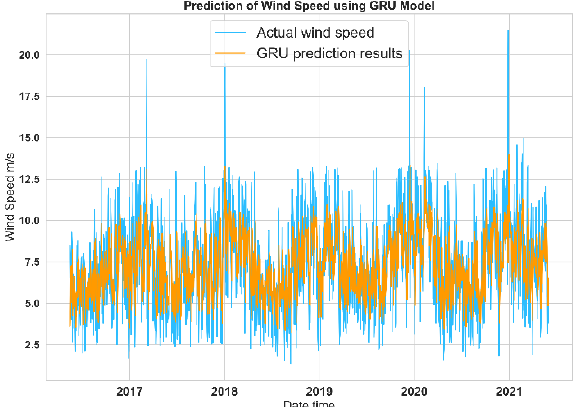
Figure 3 . Wind speed prediction results from the GRU model.